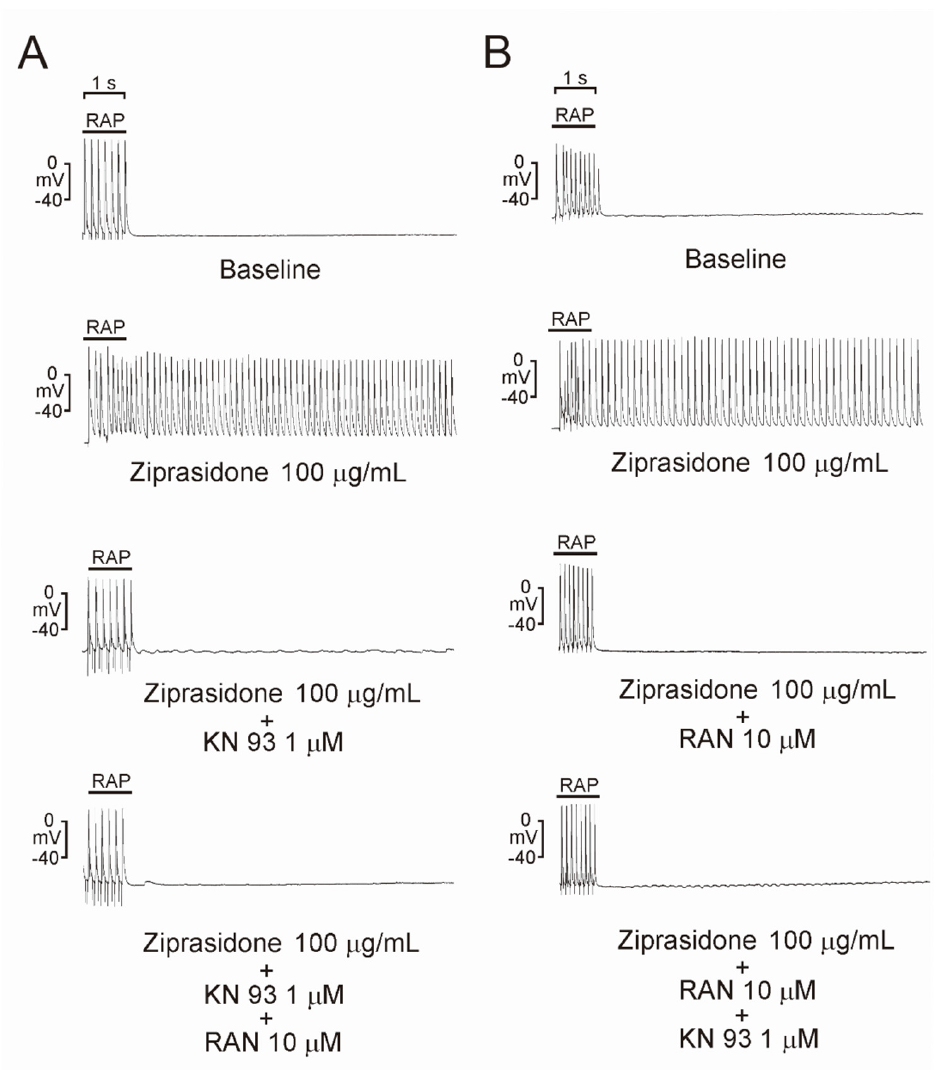
Figure 2. Triggered activity in atrial tissues with ziprasidone. Representative triggered activities in atrial tissues treated with ziprasidone. ( A ): Atrial tissues showed triggered activity with ziprasidone (100% occurrence rate, 7.5 ± 0.4 Hz sustained frequency and 19.8 ± 7.9 s sustained duration, n = 7, compared with 0% in atrial tissues without ziprasidone, n = 7). KN-93 and KN-93 with ranolazine inhibited the occurrence of triggered activity (0%, n = 7). ( B ): Atrial tissues showed triggered activity with ziprasidone (100% occurrence rate, 7.1 ± 0.5 Hz sustained frequency and 22.4 ± 10.4 s sustained duration, n = 7 compared with 0% in atrial tissues without ziprasidone, n = 7). Ranolazine and ranolazine with KN-93 inhibited the occurrence of triggered activity (0%, n = 7).